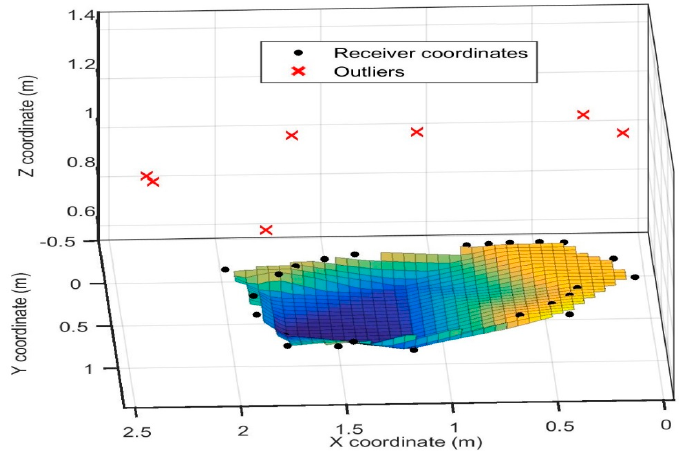
Figure 14. Motion in a circle.